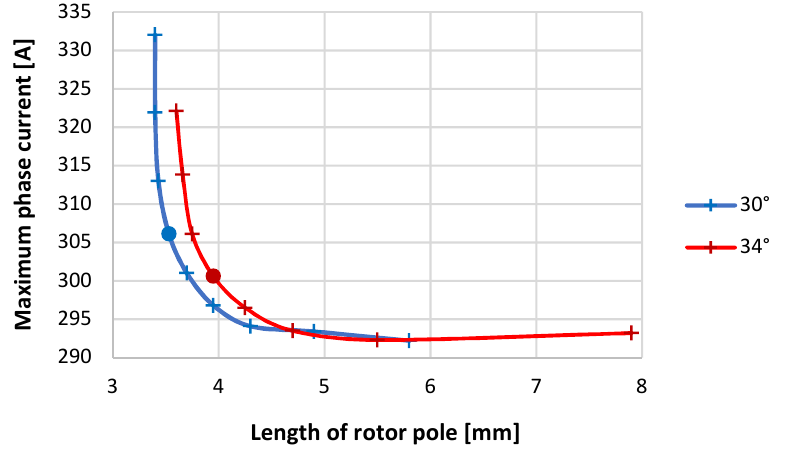
Figure 11. Possible designs with an output power of 8 kW. Each discrete point indicates a possible motor design, and the symbol • indicates the finally selected motor design.